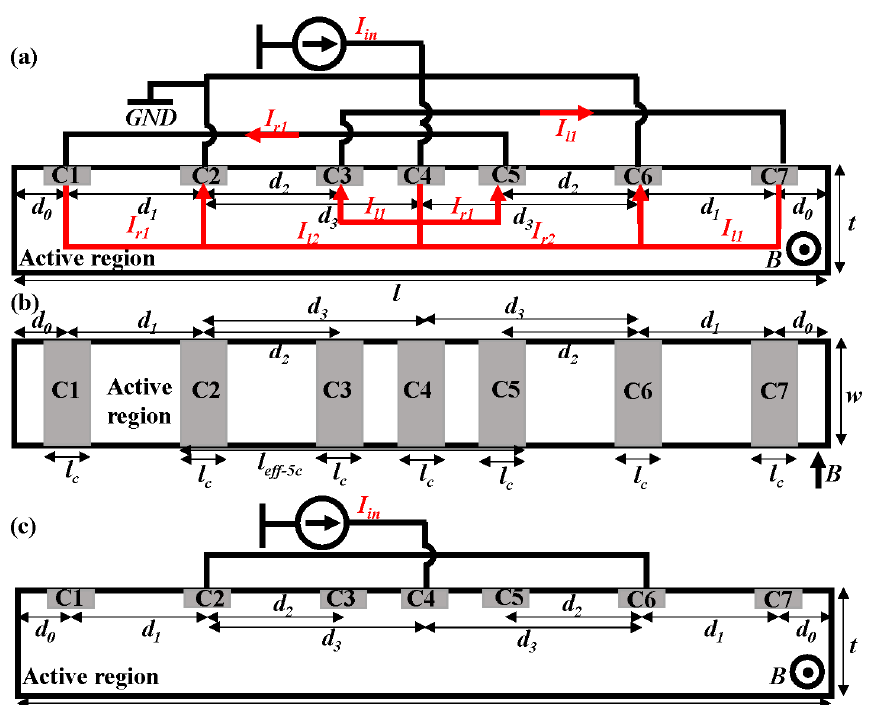
[21]. As illustrated in Table 3, the offset voltage and offset magnetic field of the 7CVHS are reduced by 99.77% and 99.56% of those of the 5CVHS, respectively, with a 43.09% current-related sensitivity loss.